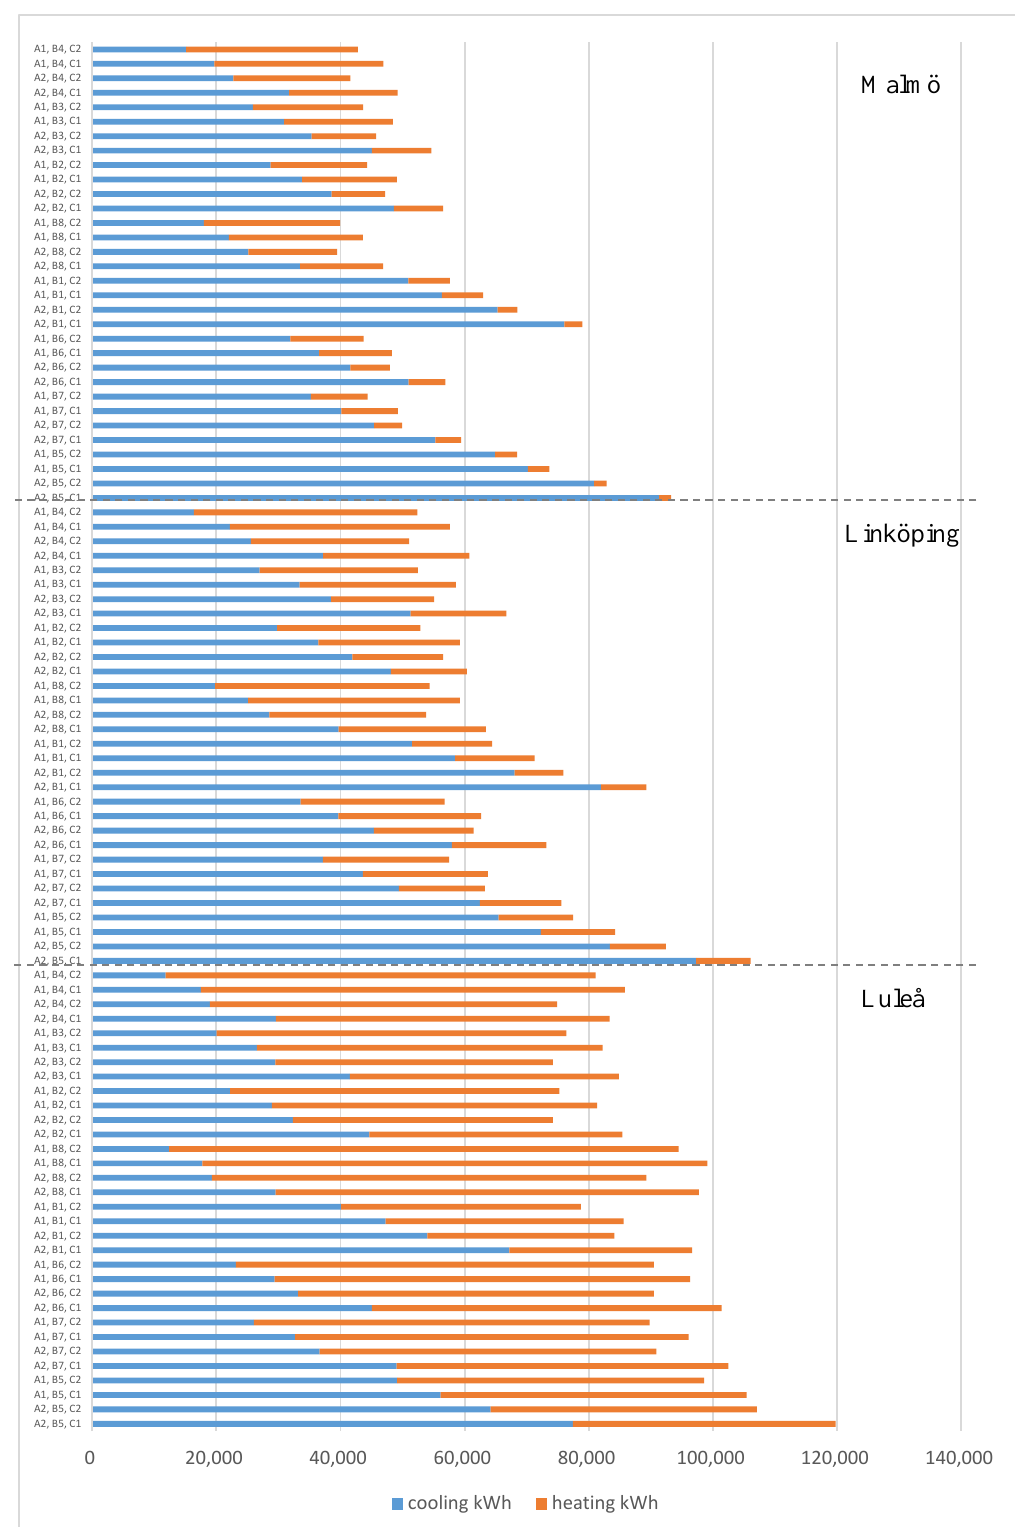
Figure 6. Total energy use, divided into heating and cooling, for all cases with the building facing north. Internal heat gains (B1–B8) are in the order from lowest to highest for each location. A1 is angled façade and A2 is straight façade. C1 is without blinds and C2 is with blinds.